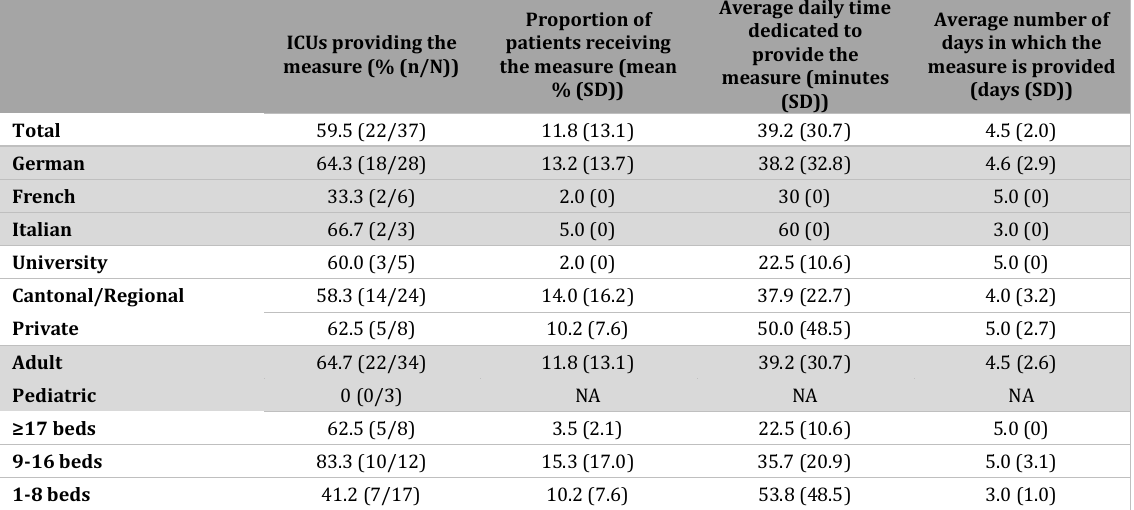
Table S11. Active cycling in bed